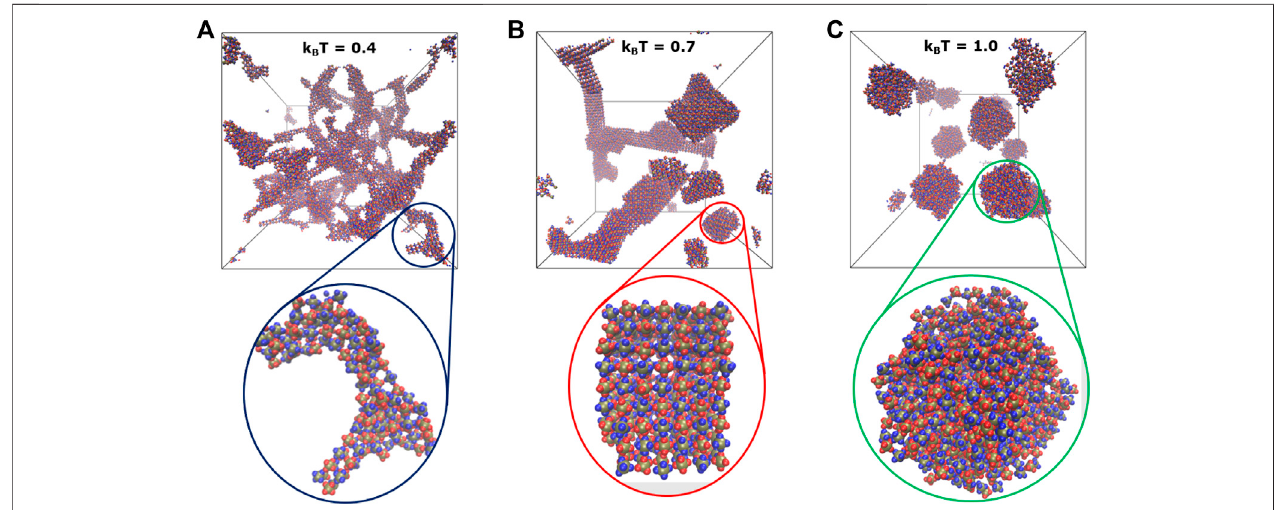
FIGURE 6 | Shown are the snapshots highlighting temperature-dependent shape transitions in self-assemblies formed by the S TB 5 particles: (A) porous network- like assemblies; (B) crystalline morphologies; and (C) spherical aggregates.